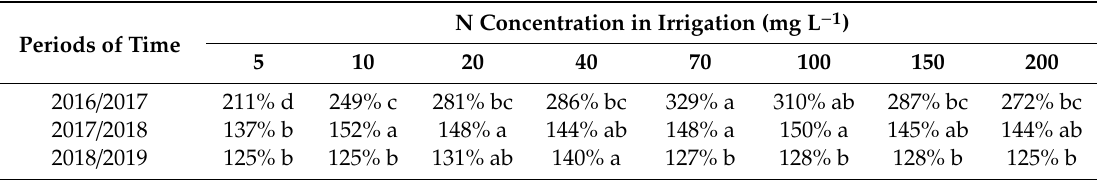
Figure 4. Changes of trunk diameter in pomegranate trees under di ff erent nitrogen levels. Numbers on the graph are the proportions of trunk diameter increase in January 2019, in relation to the first measurement (January 2016). Table 1. Annual increase of trunk diameter relative to the previous